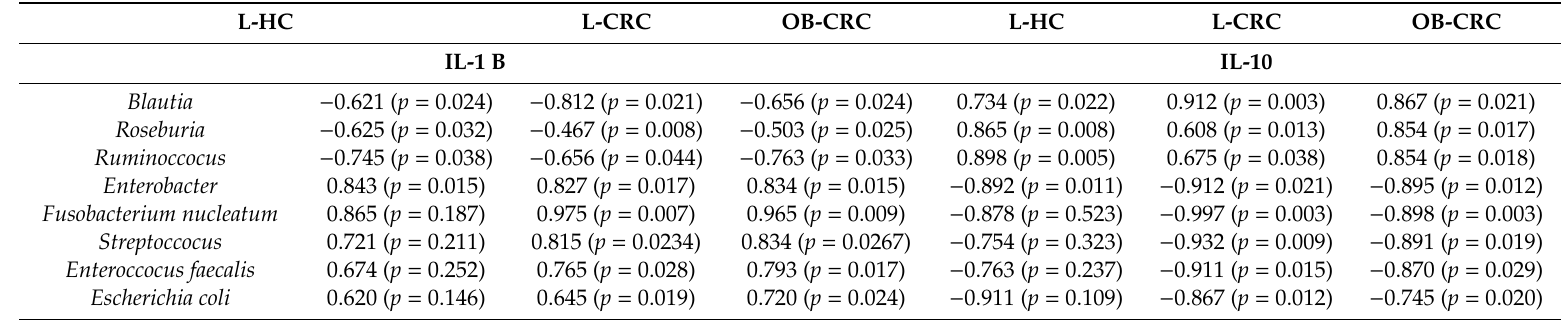
Table 2. Correlations of gut microbiota composition and serum levels of IL-1B and IL-10 in the L-CRC, OB-CRC, and L-HC groups.